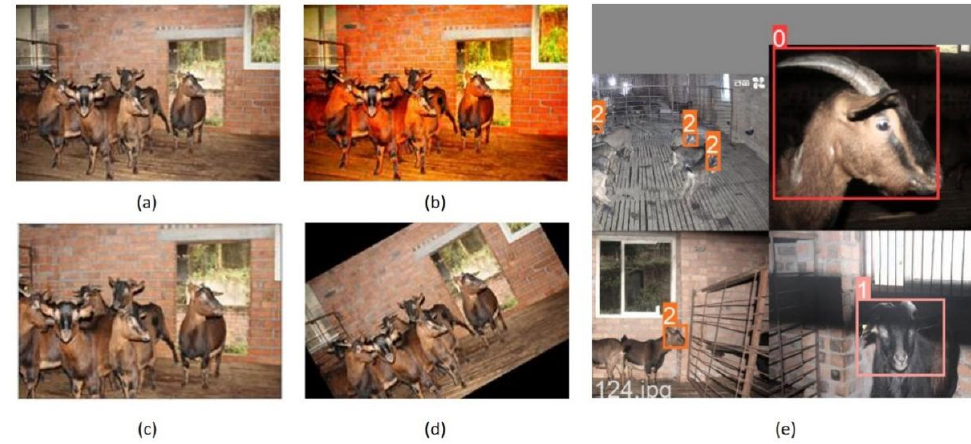
Figure 3. Some examples of data augmentation methods. ( a ): An original image. ( b ): Color dithering. ( c ): Equal scaling. ( d ): Rotation. ( e ): Mosaic, the multi-image fusion method. 0 represents ewe, 1 represents ram, and 2 represents lamb.